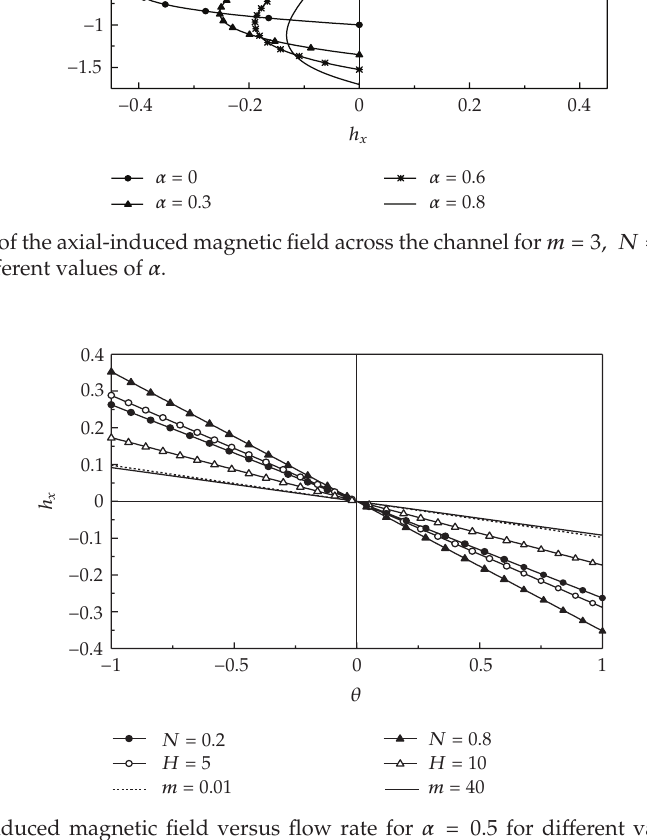
Figure 10: Axial-induced magnetic field versus flow rate for α (cid:8) 0 . 5 for di ff erent values of N at m (cid:8) 2 , H (cid:8) 4 , R m (cid:8) 2 for di ff erent values of m at N (cid:8) 0 . 7 , H (cid:8) 7 , R m (cid:8) 1, and for di ff erent values of H at m (cid:8) 4 , N (cid:8) 0 . 6 , R m (cid:8)